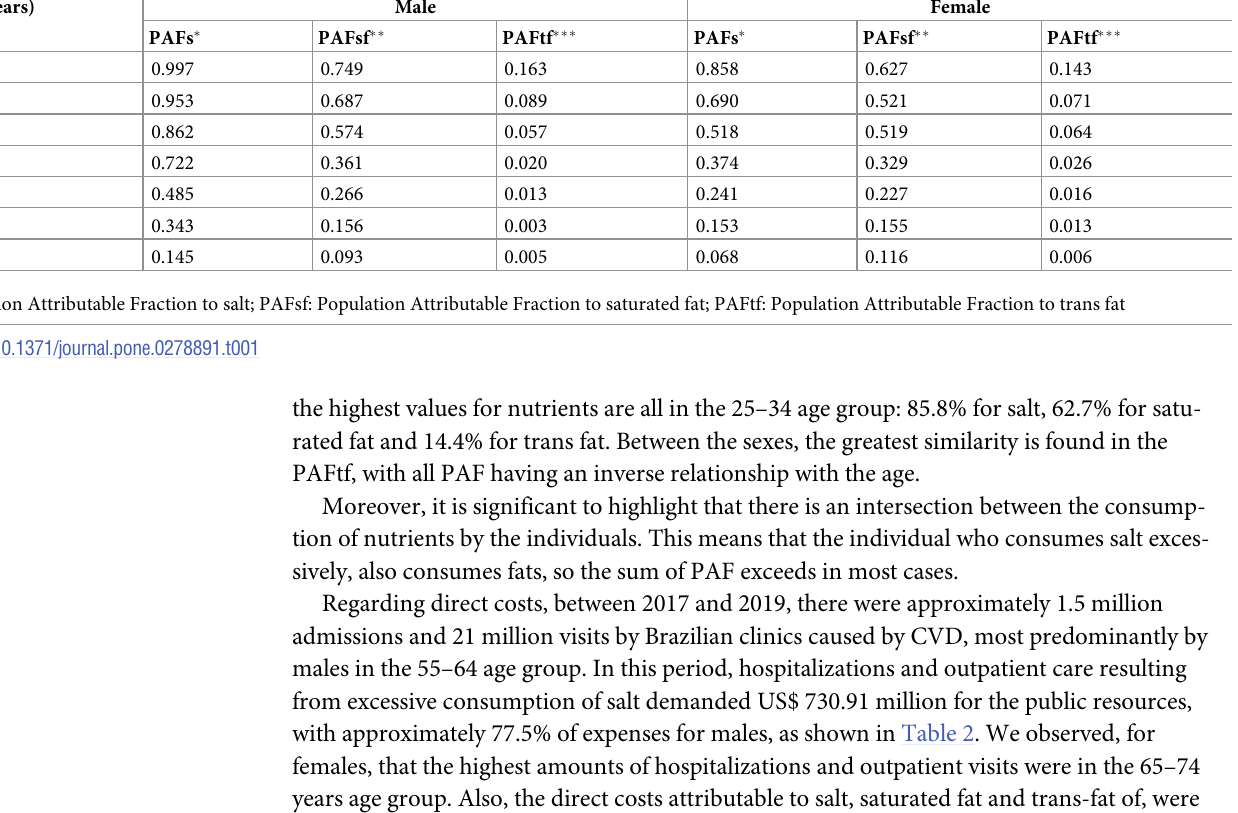
Table 1. Population Attributable Fraction (PAF) to salt, saturated fat and trans fat by age and sex. Age group